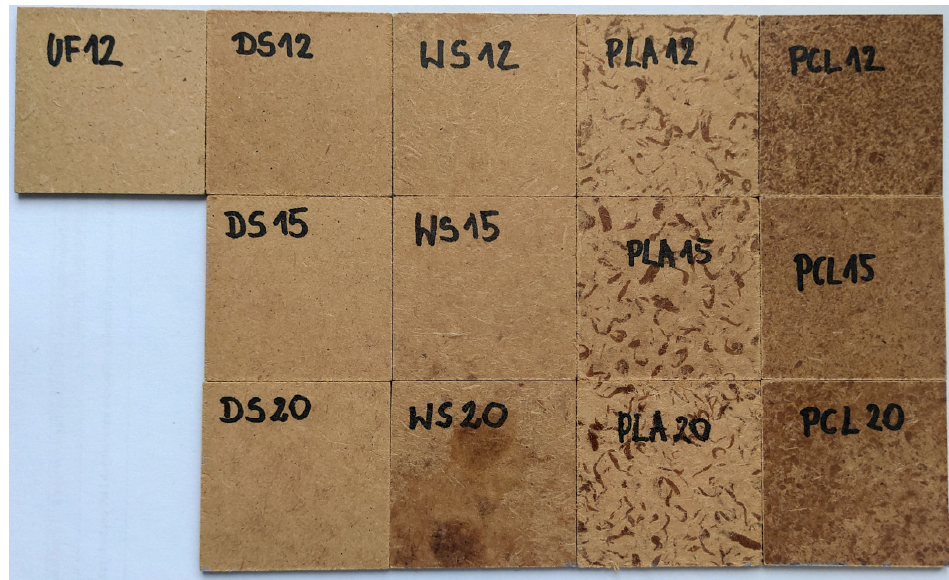
Figure 2. Changes in the appearance of the surface of the produced HDF, depending on the binder used and the resination.